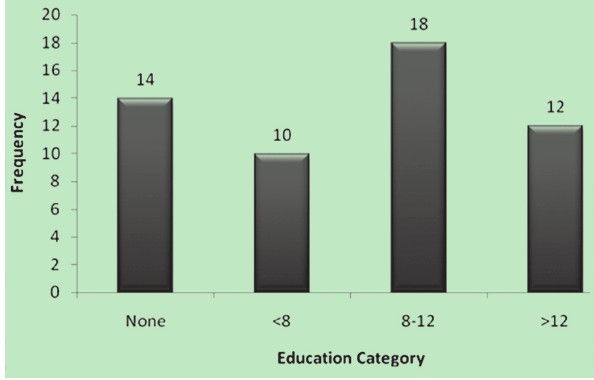
Figure 2. Educational status of the patients Overall the patients who could complete VPSS alone without anyone’s assistance was 43%. Medical personnel had to assist in 28% of the cases. On the other hand, 76% of the cases required the assistance of a doctor while completing IPSS (p< 0.001). In illiterate population all required assistance to fill up IPSS while VPSS could be filled in by self or family member in 50 % of the cases. In literate population, filling up of VPSS required assistance 2). Table 2. Requirement of assistance while completing